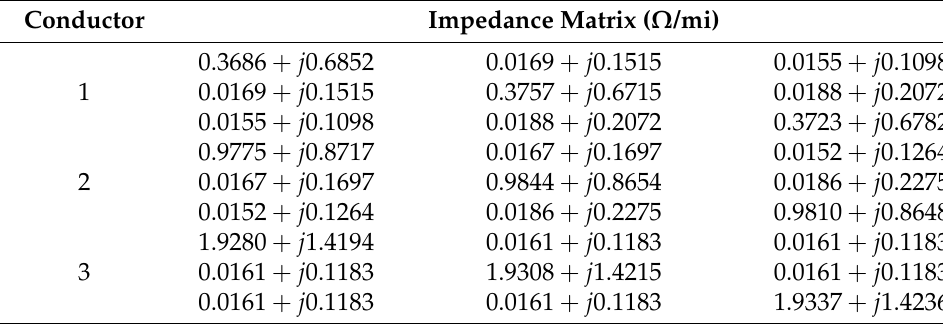
Table 3. Impedance matrix for the type of conductors in the 15-bus test system. Conductor